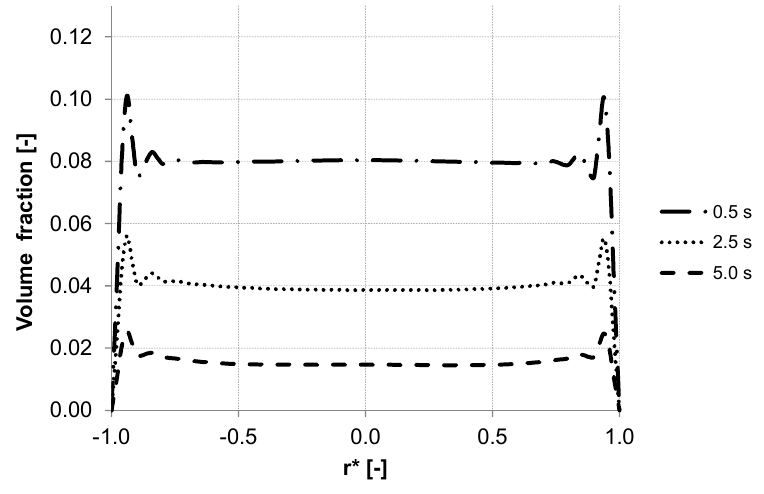
Figure 7. Particle distributions along control line C with backwashing flux of 300 L m − 2 h − 1 during 5 s (homogeneous initial distribution, particle diameter of 20